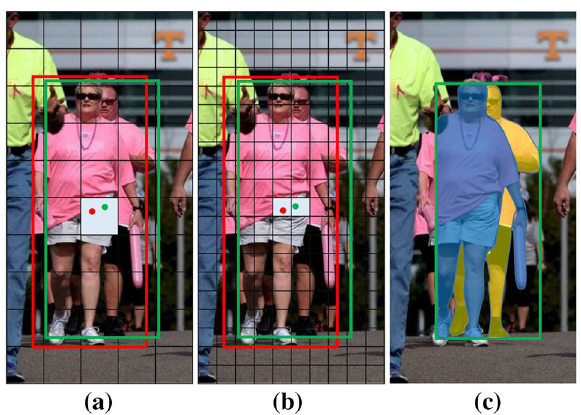
Fig.1 a Since each grid can extract only one object whose center point locates in it, heavily overlapped objects are easily ignored in original YOLO. b Finemeshingwillmakethecenterofobjectslocateindifferent grid as possible, so the heavily occluded objects can be preserved into the training process. c The visible pixels of the occluded objects are limited, as shown in the yellow region, which makes the high level semanticfeatureoftheoccludedobjectsarehardlydistinguishablefrom the ones who cover